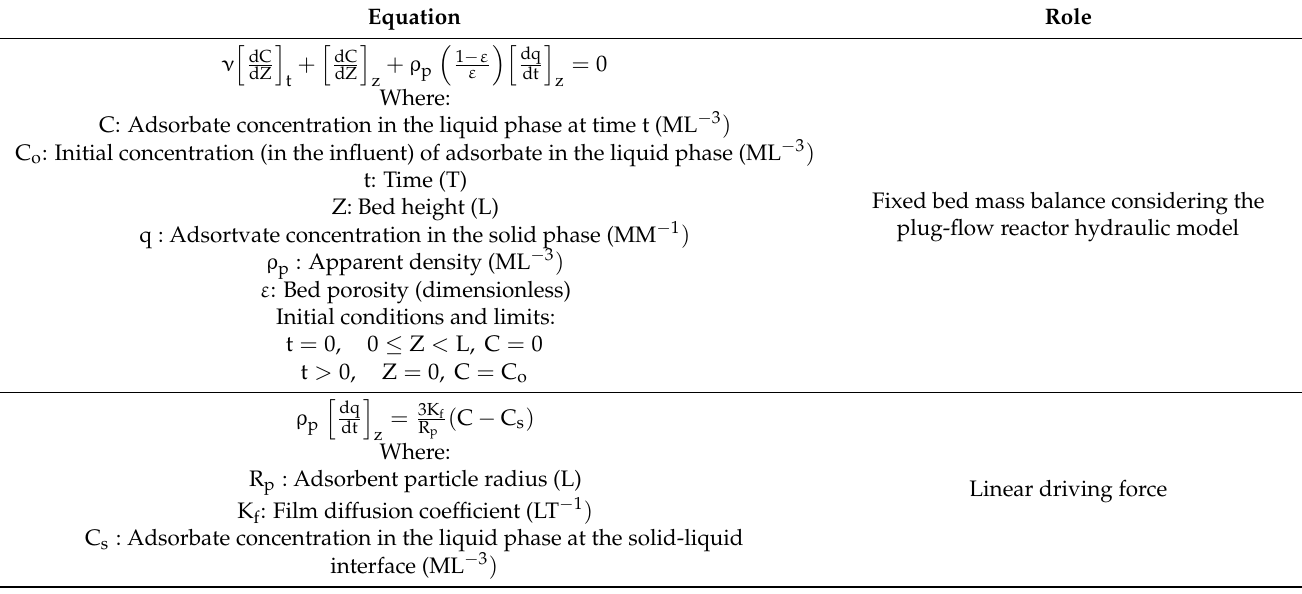
Fixed bed mass balance considering